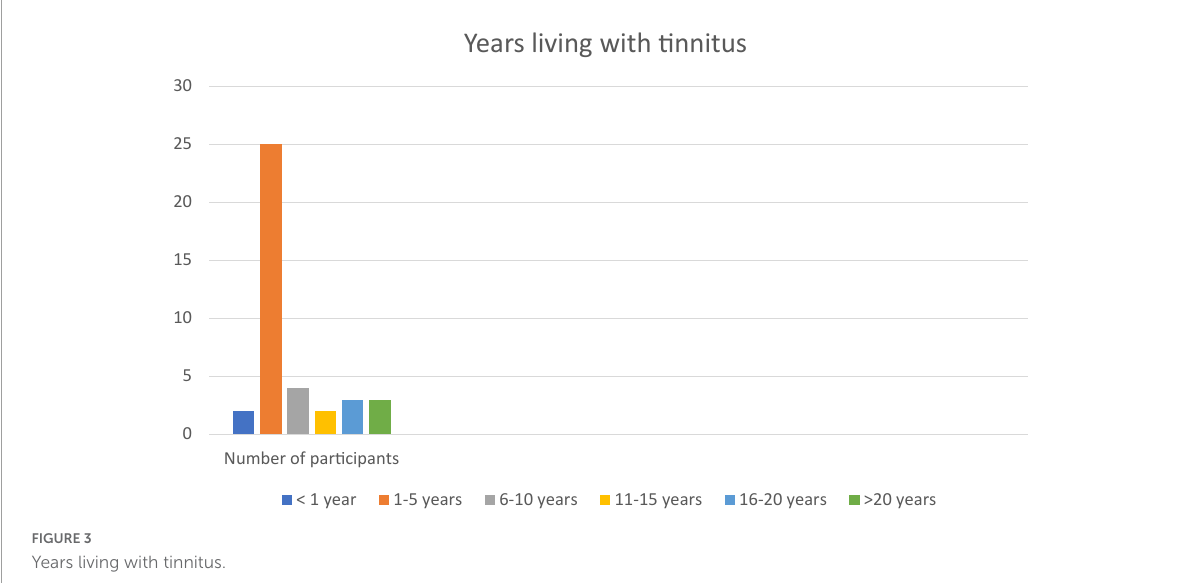
FIGURE3 Years living with tinnitus.